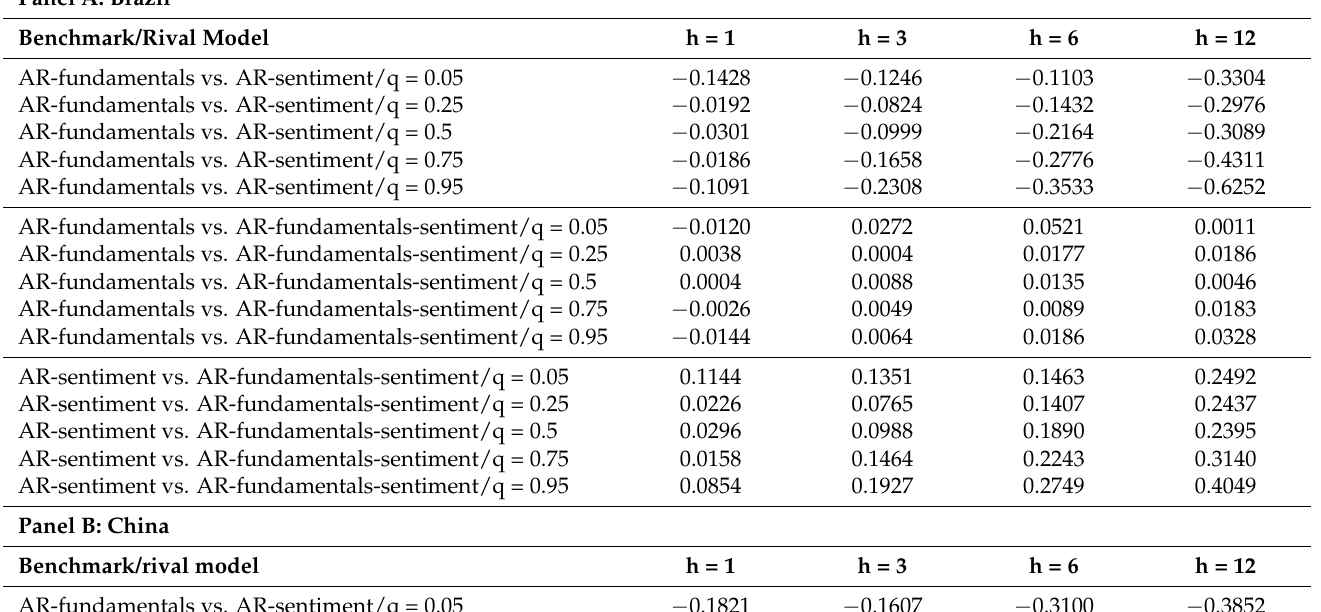
Table A7. Results for other BRIC countries (NYT